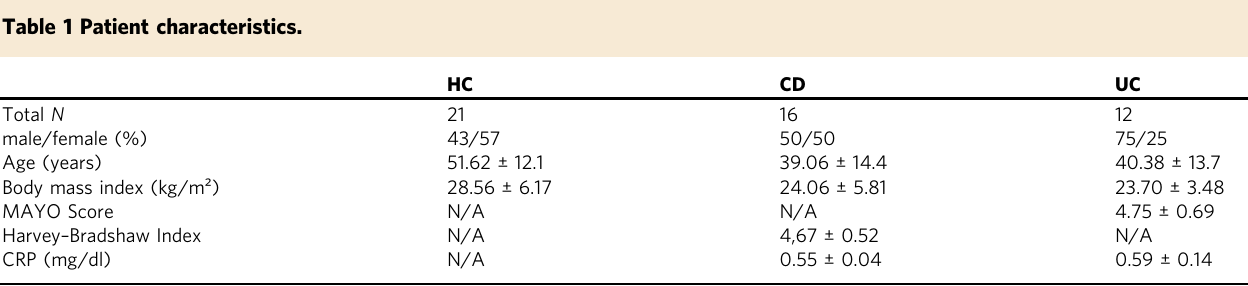
Table 1 Patient